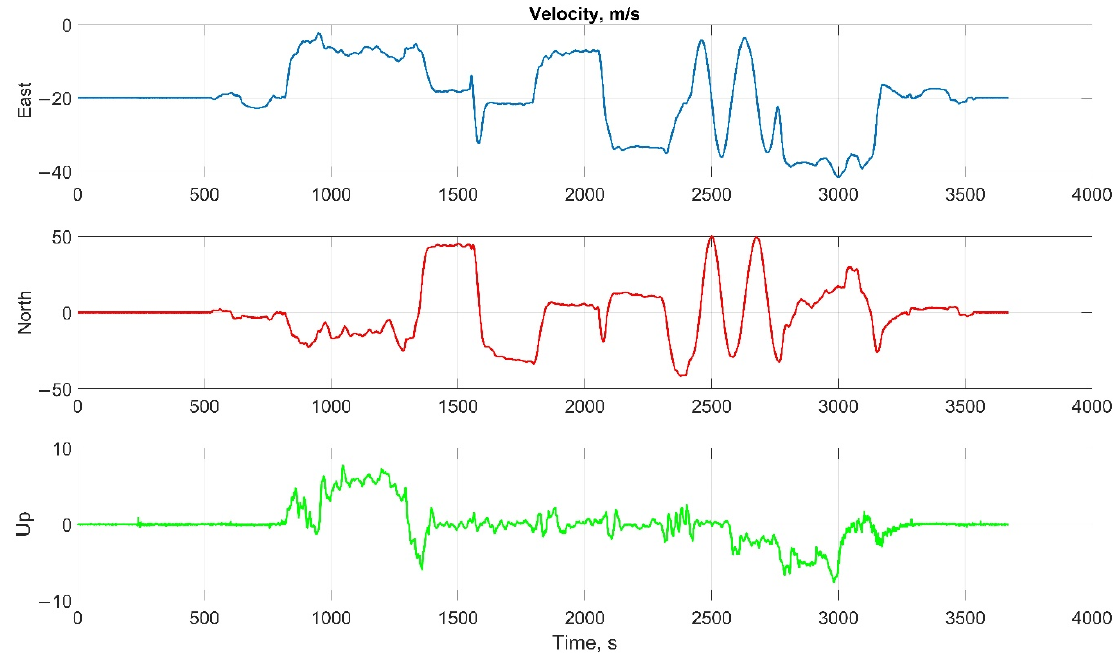
Figure 16. The north, east, and up velocity projections in helicopter test.